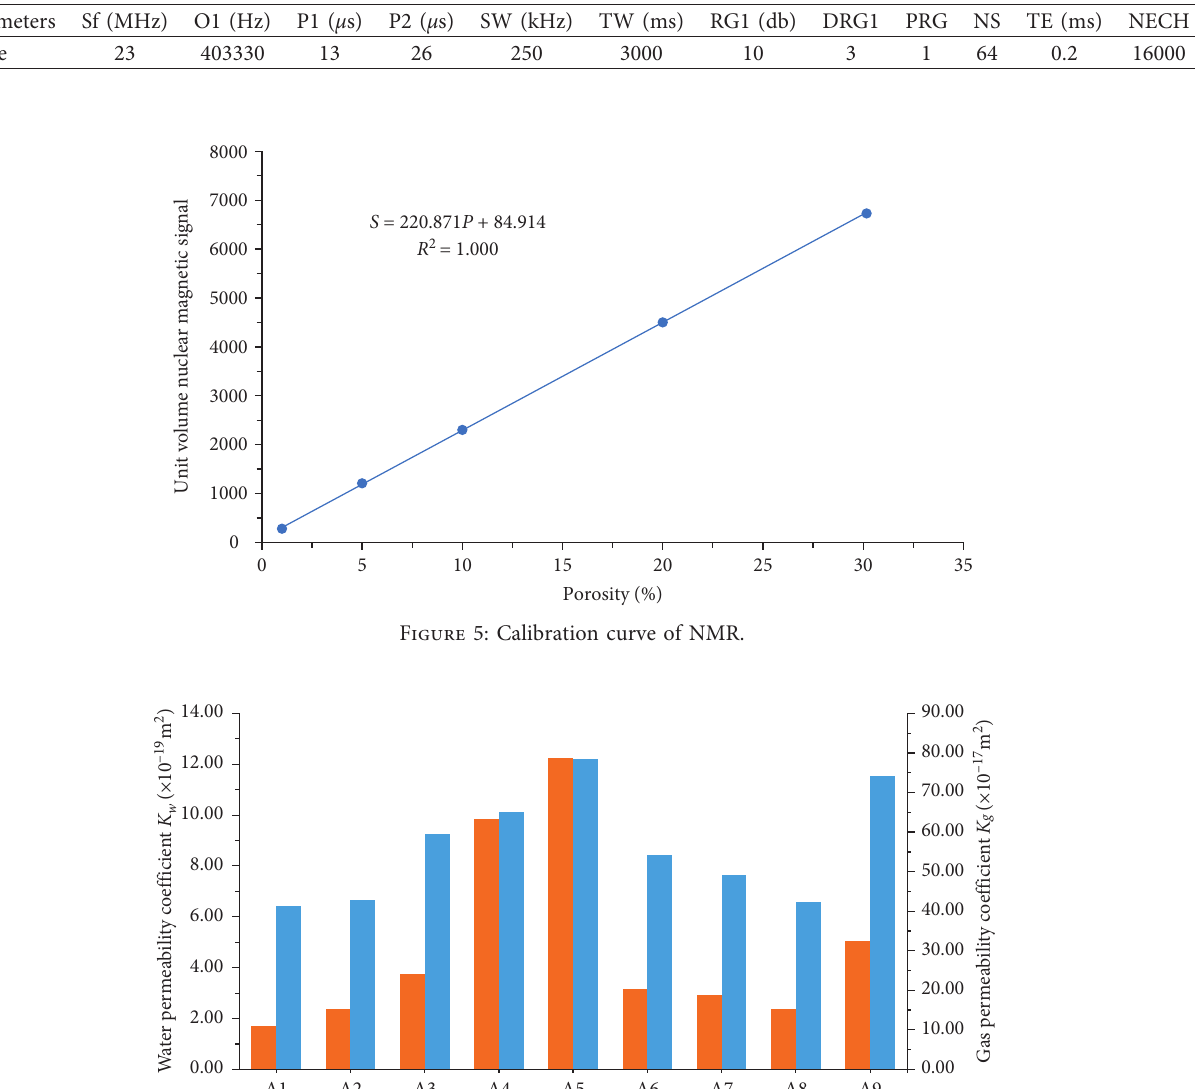
Table 4: CPMG parameters used in test.